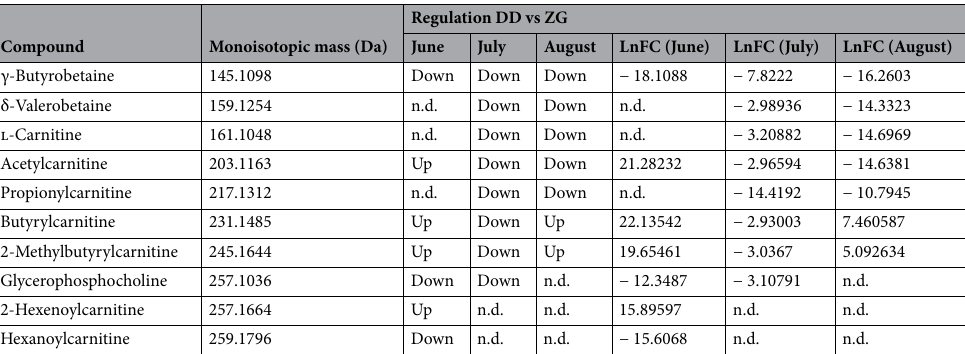
Table 2. Metabolites obtained from LC–MS data (positive mode), that are differentially accumulated in milk samples from buffaloes of DD Group (fed a total mixed ratio (TMR)) and ZG Group (fed TMR + 30% of green forage) analyzed for 3 months (June, July and August). Identifications were performed by comparing results with known compounds present in freely available electronic databases. Milk Composition Database (MCDB) and Bovine Metabolome Database (BMDB) were used for the identification. Up, up regulated; Down , down regulated; n.d. , compounds not detected after statistical analysis. LnFC, Natural logarithm of Fold Change.